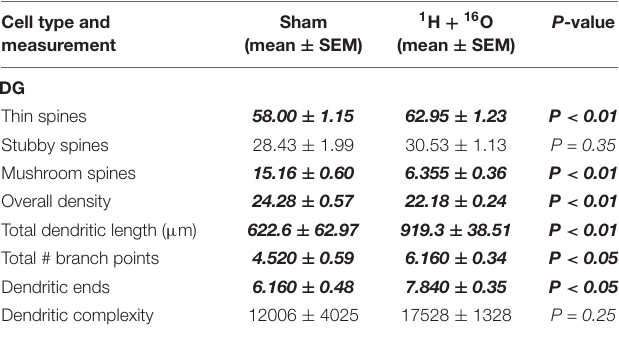
TABLE 1 | Effects of 1 H + 16 O irradiation on dendrite morphology in the